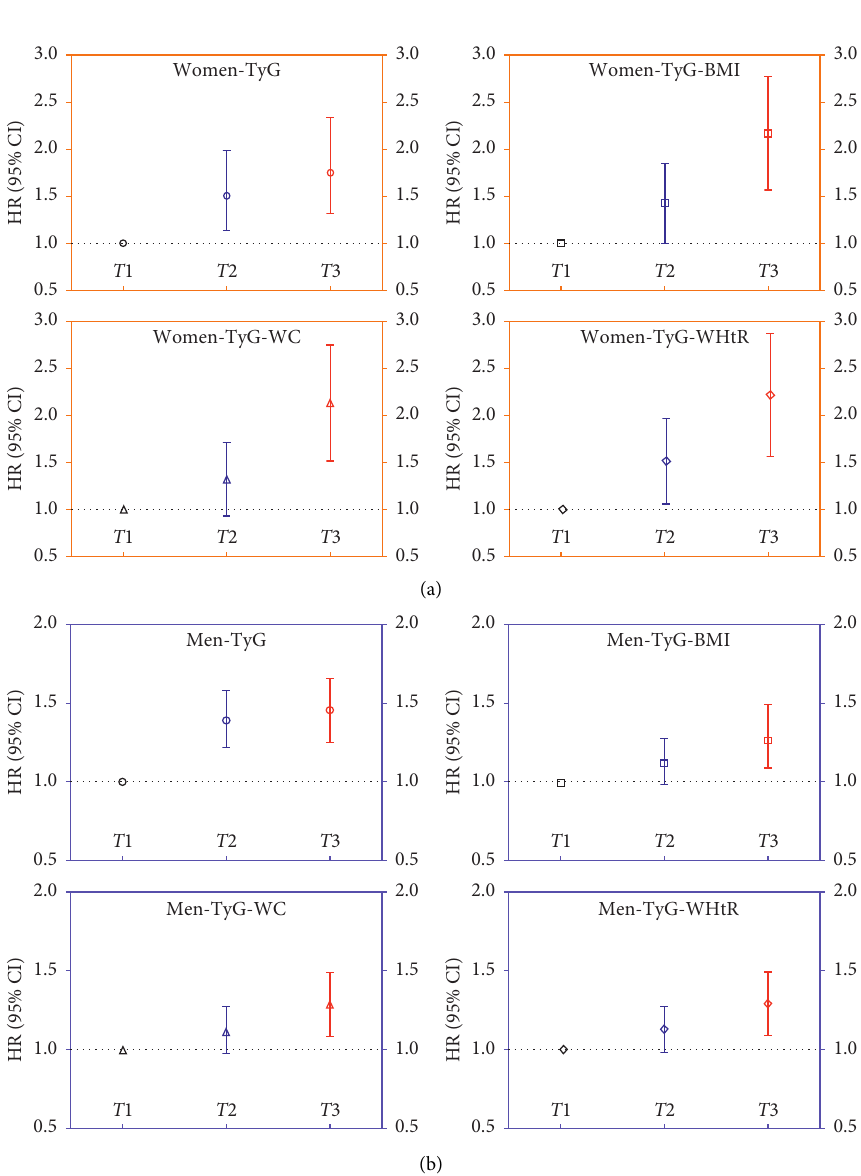
Figure 2: Hazard ratios and 95% confidence intervals for the incidence of hyperuricemia in the tertiles of TyG and its derivatives. The multivariate adjusted HR are adjusted for baseline age, smoking status, overweight/obesity, hypertension, nonalcoholic fatty liver, eGFR, and urate; HR, hazard ratios; CI, confidence intervals; ( T ) tertile; TyG, triglyceride and glucose index; BMI, body mass index; WC, waist circumference; WHtR, waist-to-height